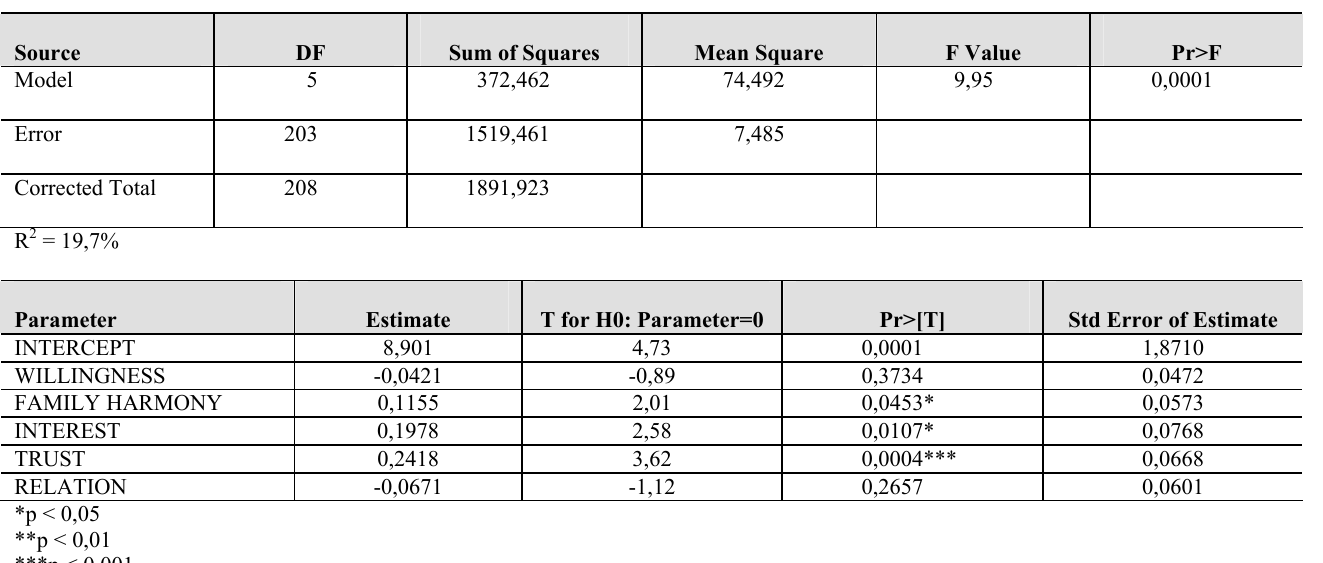
Table 5: Multiple regression results for successor sub-sample: P